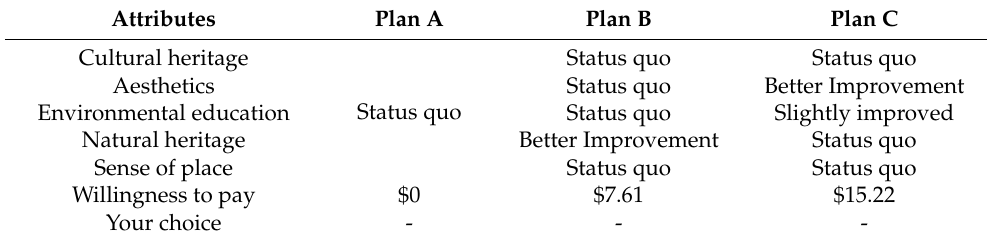
Table 3. Choice set